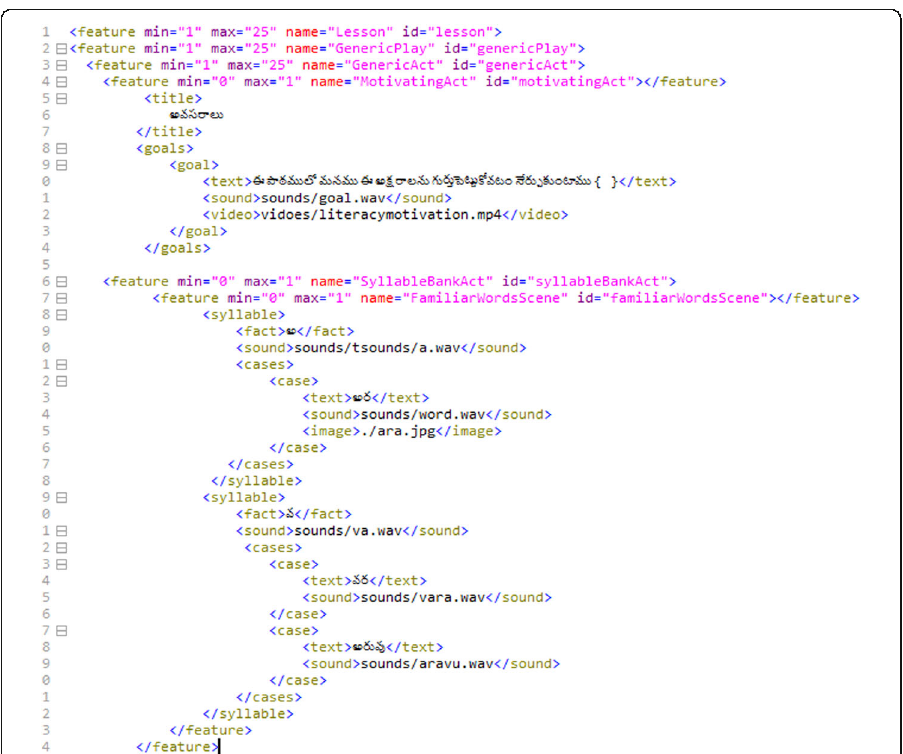
Fig. 10 A fragment of instance of MotivatingAct and SyllableBankAct for Telugu language